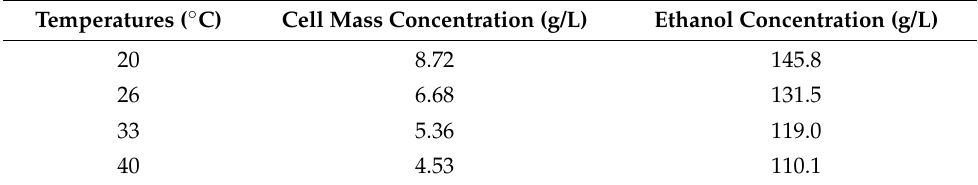
Table 3. Final values after a 60 h simulation for cell mass concentration and ethanol